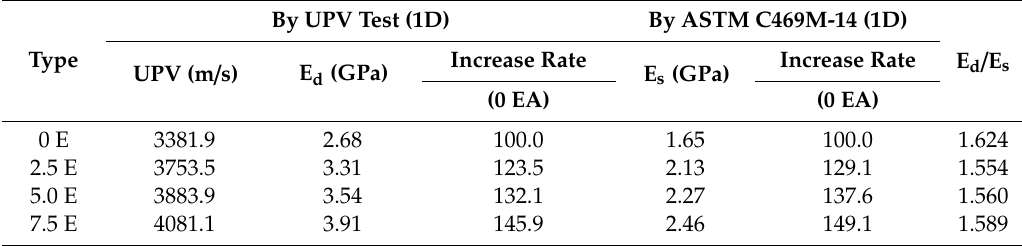
Table 5. UPV and dynamic and static moduli of elasticity of the AAM mortar at one day of age.